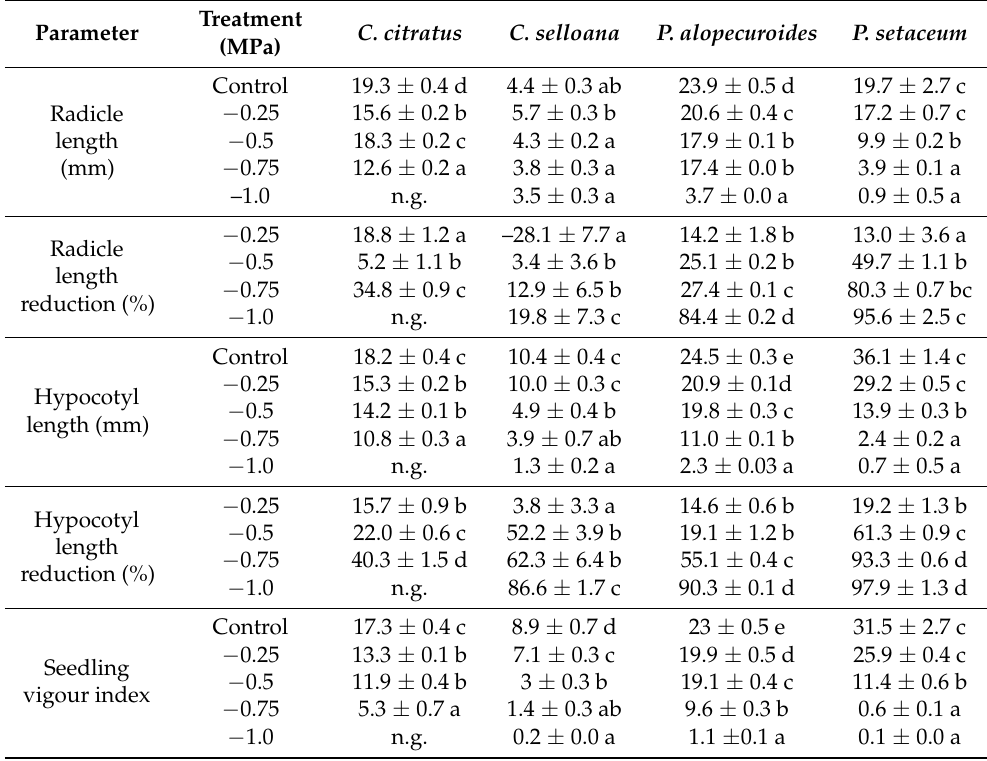
Table 2. Seedling’s parameters (means ± SE; n = 4), calculated for the four studied species in the 30-day germination assays. Different lowercase letters indicate significant differences between treatments per species, according to the Tukey test ( p < 0.05). n.g.: no